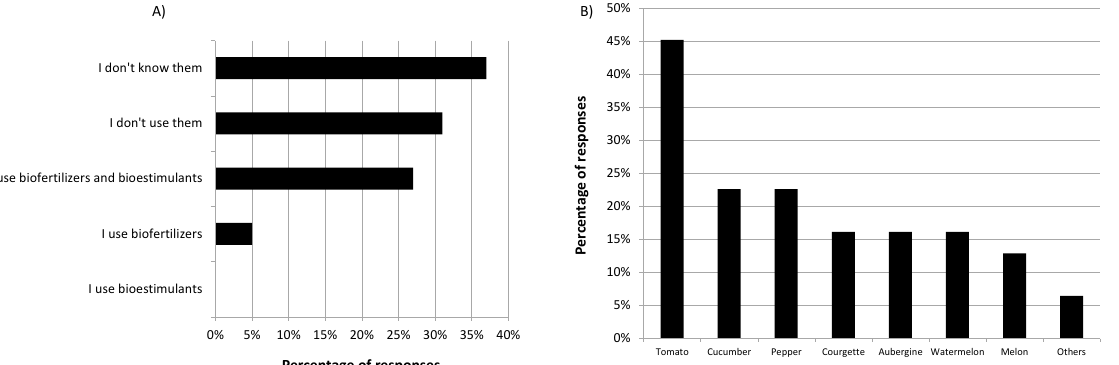
Figure 3. ( A ) Farmers’ knowledge and use of microalgae as biostimulants and biofertilizers in agriculture. ( B ) Successful crops using microalgae.